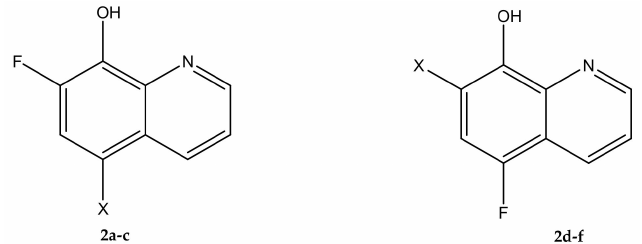
Figure 2. Analogs of clioquinol (CQ). X = Cl, Br, I [31].